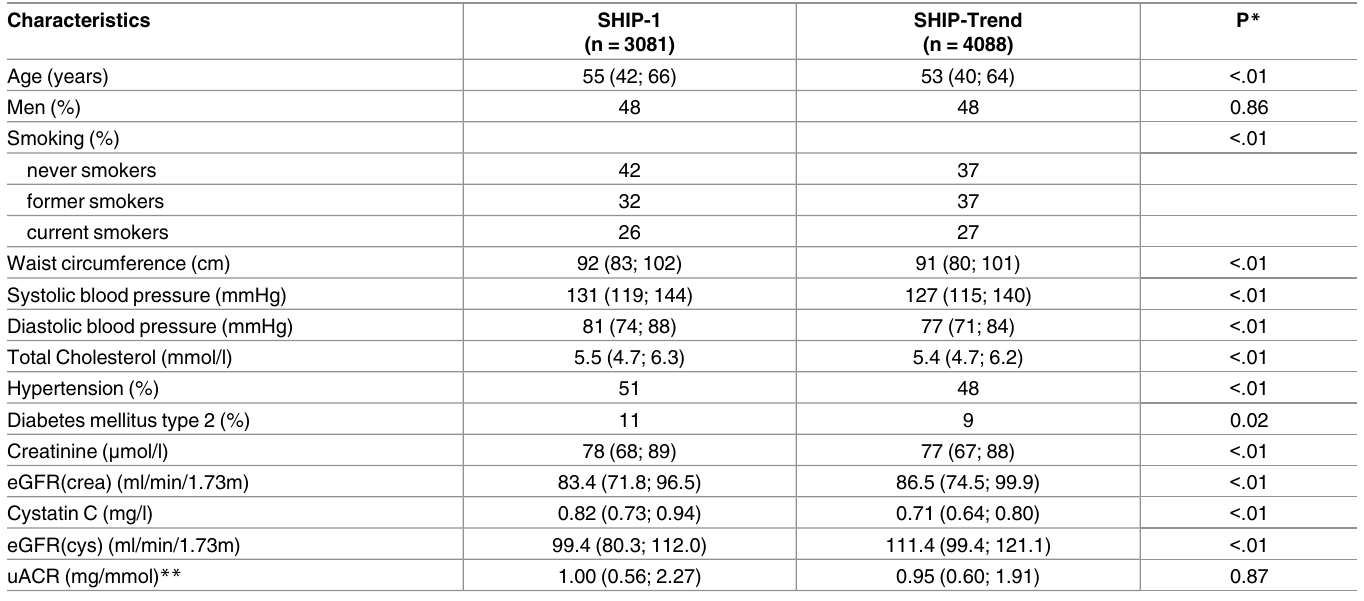
Table 1. Baseline characteristics stratified by study population.